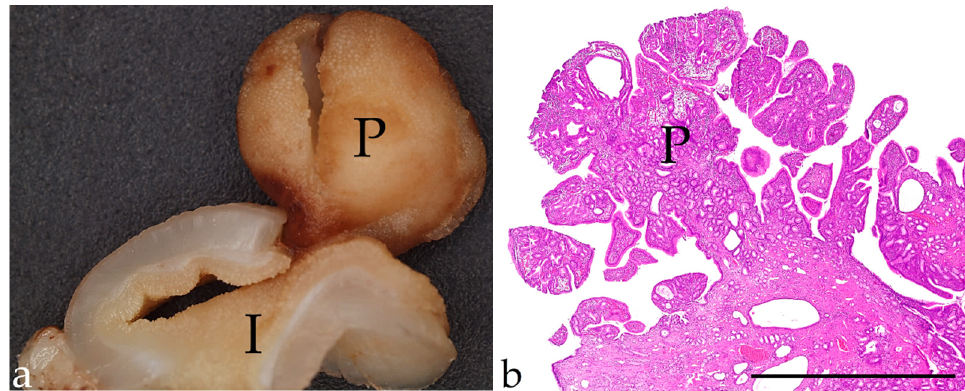
Figure 7. Intestinal polyp. ( a ): Macroscopy of a 1.5 cm polyp (P) within the small intestine (I) of a 13-year-old male castrated DSH. ( b ): Histology of a small intestinal polyp (P) in a 12-year-old female spayed DSH; (HE stain, bar = 2 mm).